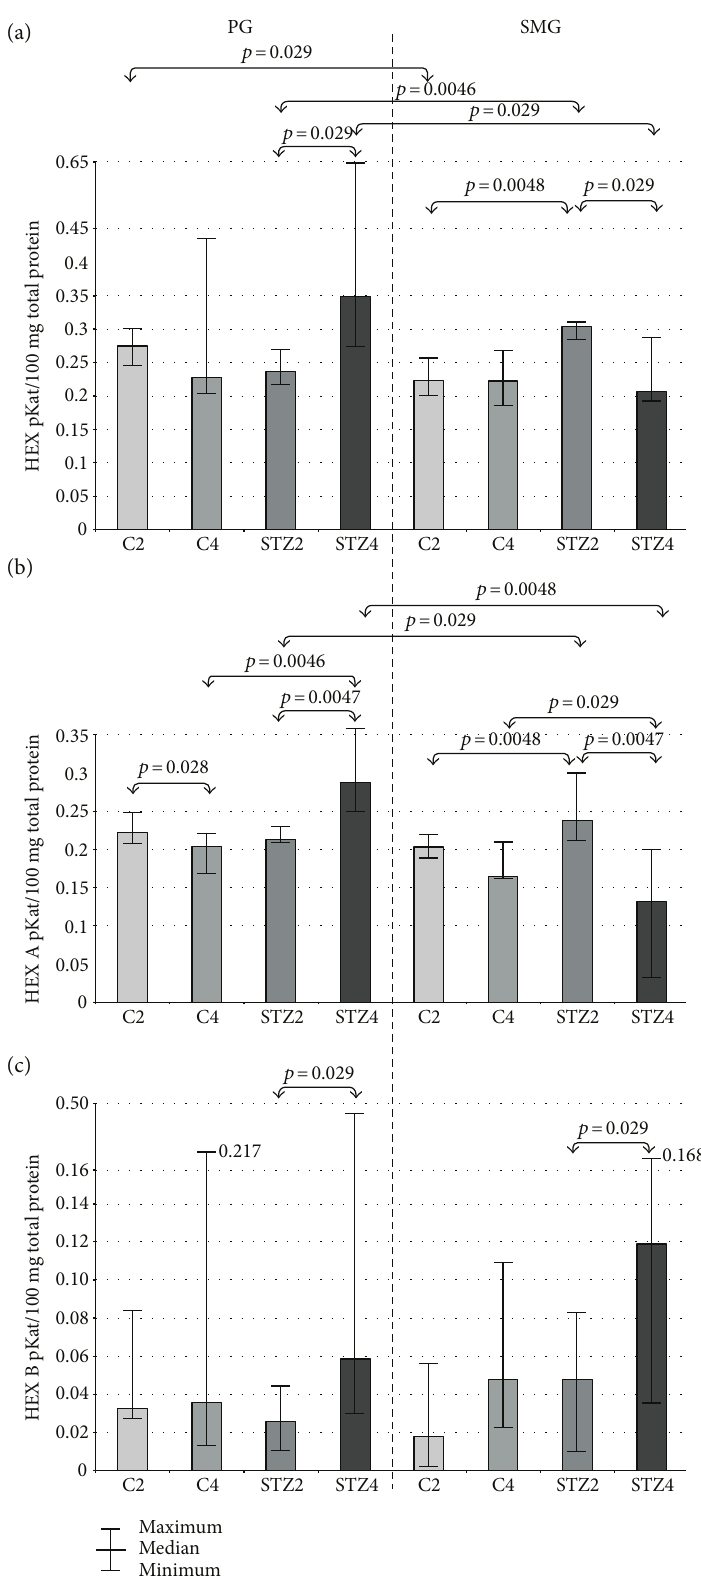
Figure 1: The e ff ect of STZ-induced diabetes on activity of HEX, HEX A, and HEX B in the parotid and submandibular glands of rats. C2 and C4 are the control groups; HEX: N-acetyl- β -hexosaminidase; HEX A: N-acetyl- β -hexosaminidase A; HEX B: N-acetyl- β - hexosaminidase B; PG: parotid glands; SMG: submandibular glands; STZ2 and STZ4 are the diabetic